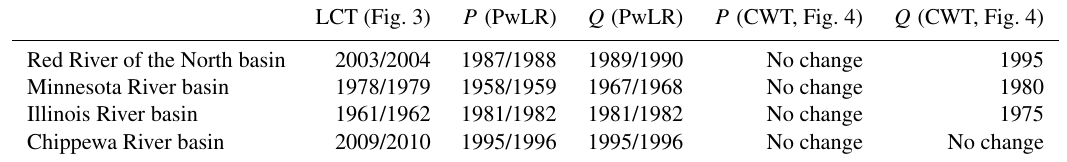
Table 3. Summary of the breakpoint years identified from land cover transition (LCT) (Fig. 3), piecewise linear regression (PwLR) of precipitation ( P ) and streamflow ( Q ), and continuous wavelet transform (CWT) of P and Q (Fig. 4). LCT (Fig. 3) P